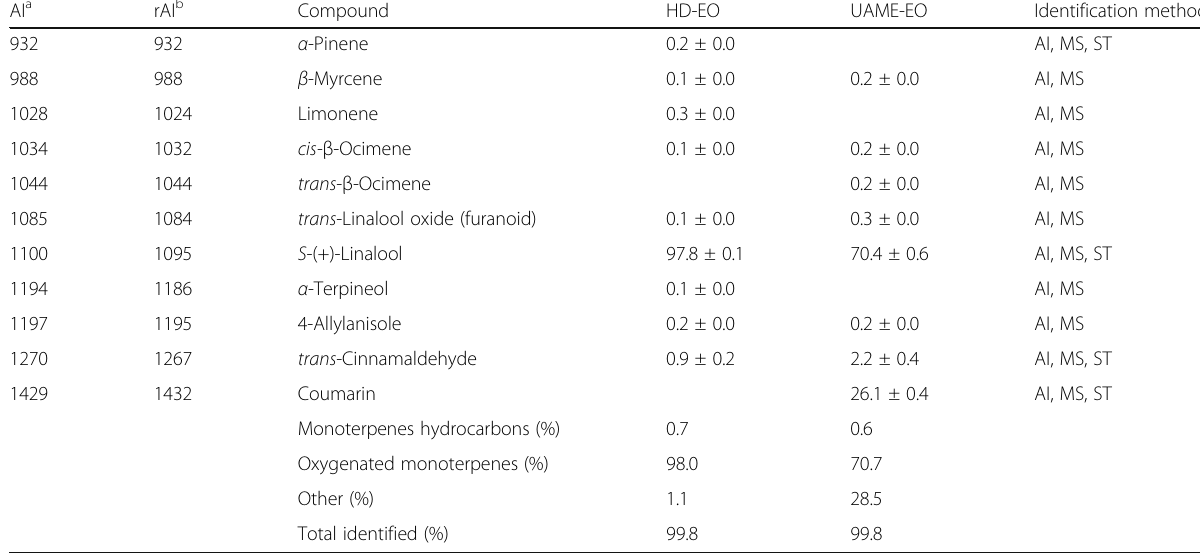
Table 1 Chemical composition (%) of LEOs extracted by hydrodistillation (HD) and ultrasound-assisted microextraction (UAME) AI a rAI b